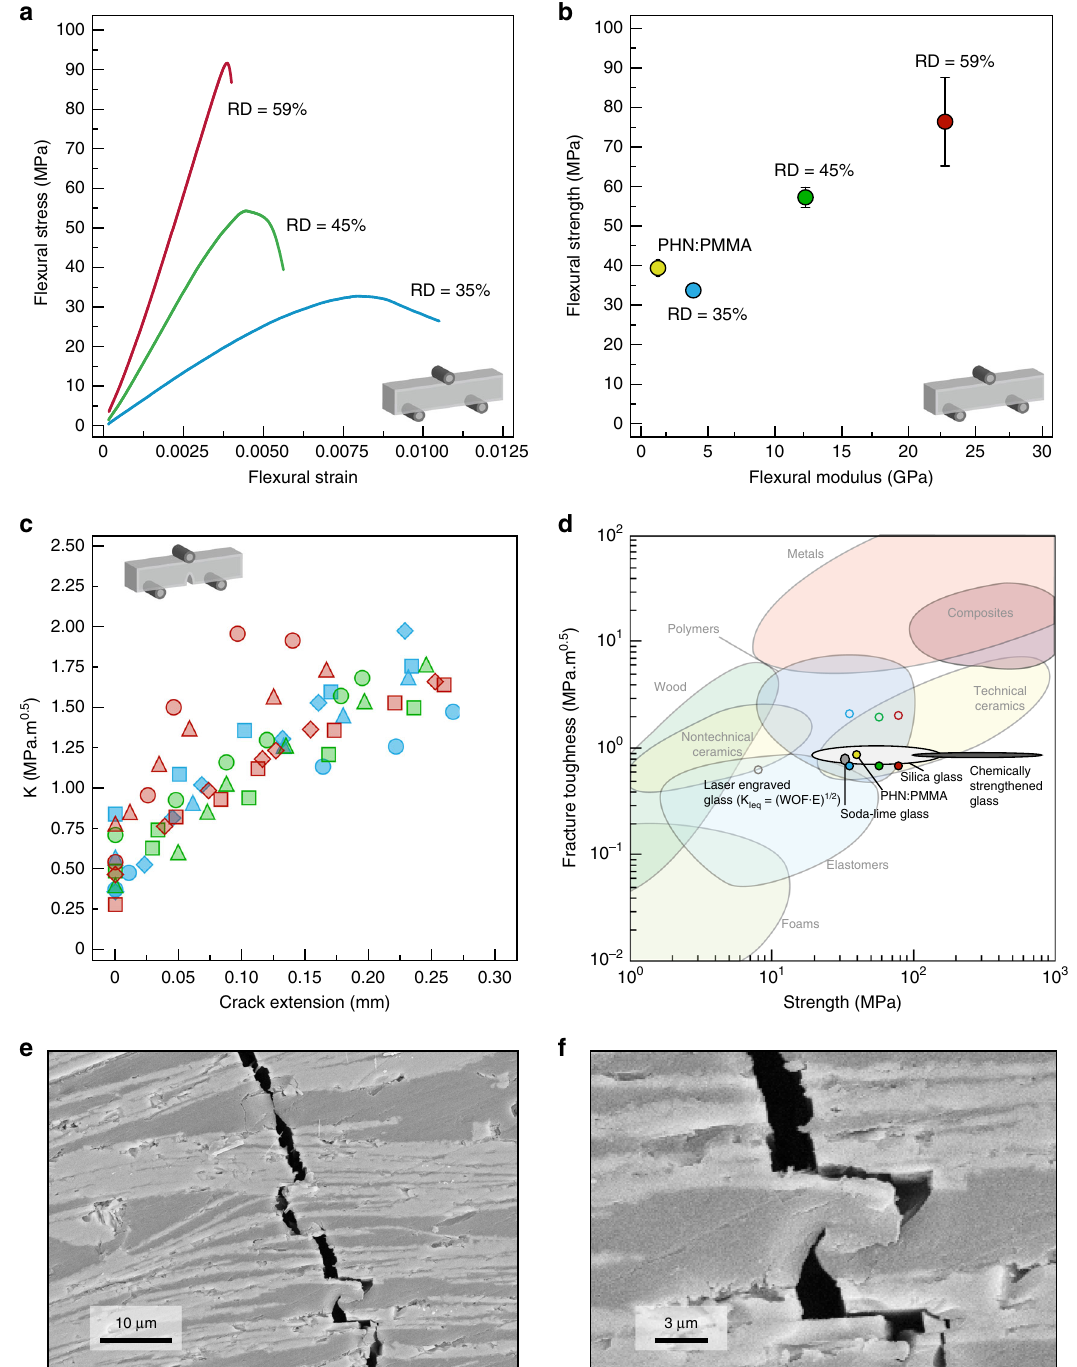
Fig. 3 Mechanical characterization of the composites. a Flexural stress as a function of fl exural strain for three composite beams with mineral contents of 35% (blue), 45% (green), and 59 vol% (red). b Flexural strength and elastic modulus of the composites and of the PHN:PMMA organic matrix (yellow tone). The error bar represents the measured standard deviation. c Crack growth resistance curves of the bulk nacre-like composites. Force-displacement curves are provided in Supplementary Fig. 5 along with a video of the crack propagation in a 35% dense specimen (Supplementary Movie 1). d Ashby plot of strength against fracture toughness for different classes of glass-based transparent materials. Our transparent nacre-like bulk composites, soda-lime glass 33 , silica glass 33 , borosilicate glass 34 , chemically toughened glass 35 , and laser engraved glass 34 are highlighted. The data for the transparent nacre-like bulk composites are indicated by blue, green, and red circles, which correspond to specimens with 35, 45, and 59% relative density, respectively. Filled and empty circles represent K IC and K IJ max , respectively. Adapted from ref. 33 . e , f Scanning electron micrographs highlighting the fracture path within the composite ( e ) and a detail of the plastic deformation of the polymer ( f